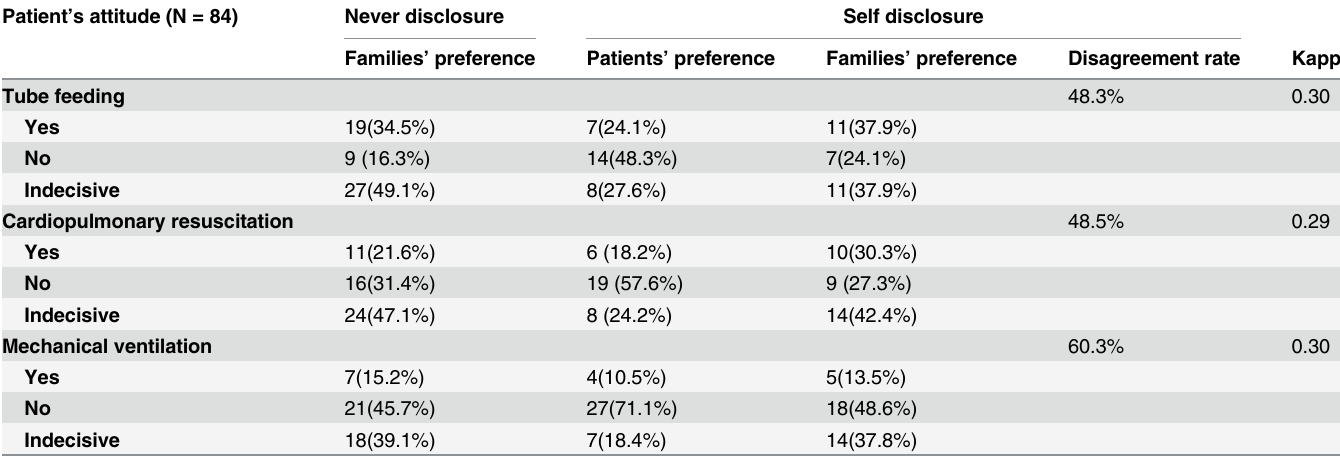
Table 2. Preferences for life-sustaining treatments reported by patients and their family